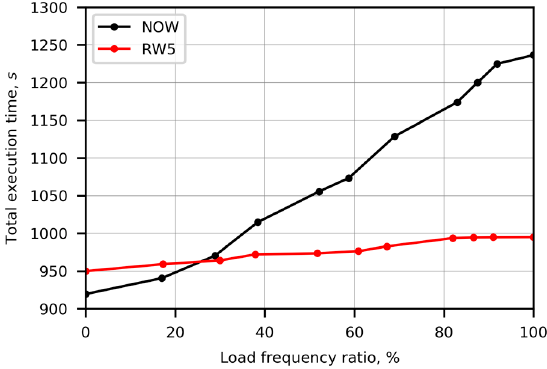
Figure 7. The dependency of the total execution time on the load frequency ratio in Case 6.